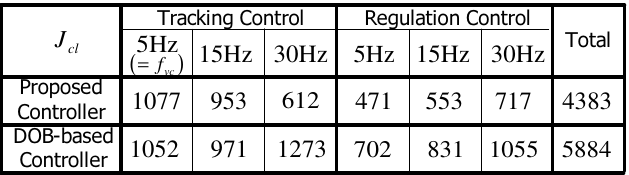
Figure 14. Performance comparison result for tracking and regulation